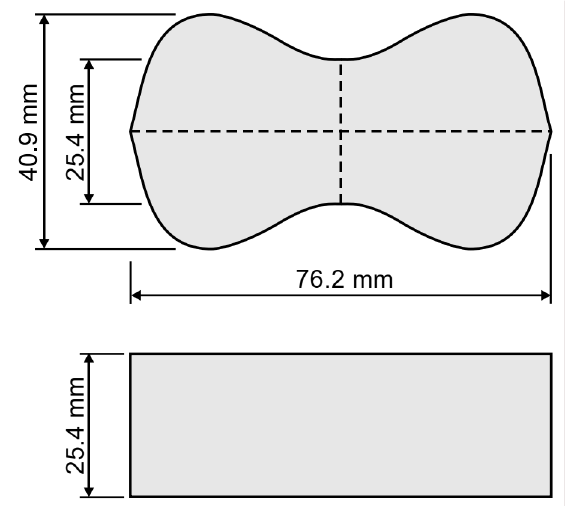
Figure 1. Briquette specimen according to ASTM C307.